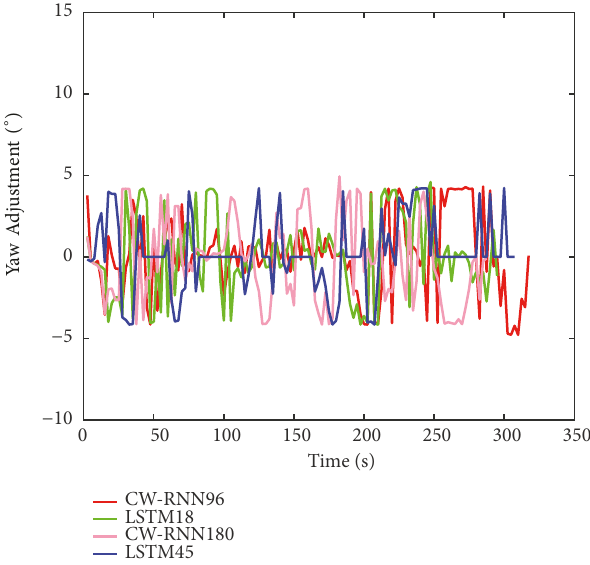
Figure 11: Curves of yaw adjustment output by the four obstacle avoidance algorithms in simulation test case 2.